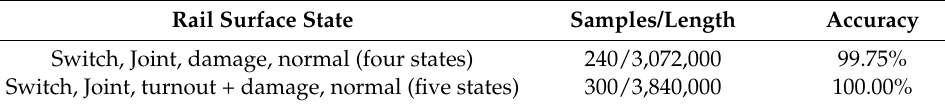
Table 10. Identification performance of mixed rail surface defects.